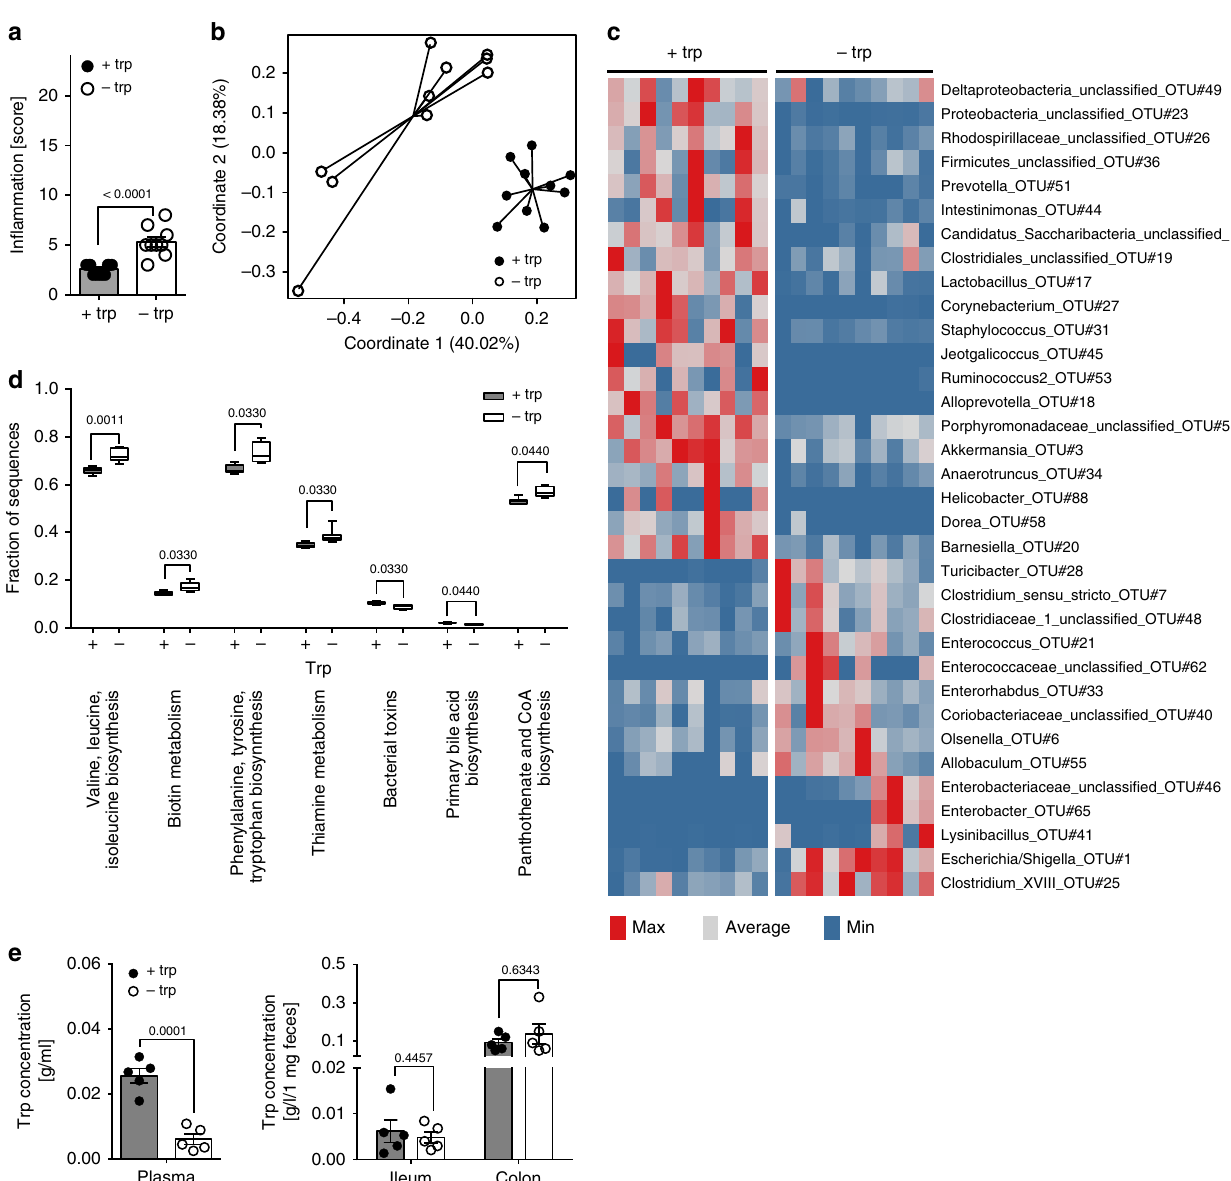
Fig. 5 DTR alters gut microbiota composition. a Histopathological gut in fl ammation score of EAE mice on d14 post-immunization ( + trp: n = 10; − trp: n = 10). b – d Pro fi ling of microbial communities by 16S rRNA gene sequencing for mice from a . b Principal coordinate analysis (PCoA; Bray-Curtis) on colonic microbial communities. c Relative abundance of signi fi cant bacterial indicator genera depicted by a heatmap. d Predicted functional categories as determined by PICRUSt. e Analysis of trp levels in plasma, feces, and ileal contents of EAE mice on d13 post-immunization ( + trp: n = 5; − trp: n = 5). Statistics: Mann – Whitney U -test for a – d ; unpaired two-tailed Student ’ s t -test in e . In d the Mann – Whitney U -test was performed for pair-wise comparisons with the control group and p values were corrected according to Benjamini – Hochberg. Each dot represents one individual mouse. Data are presented as mean ± SEM. Source data are provided as a Source Data fi le or in Supplementary Data 2 –